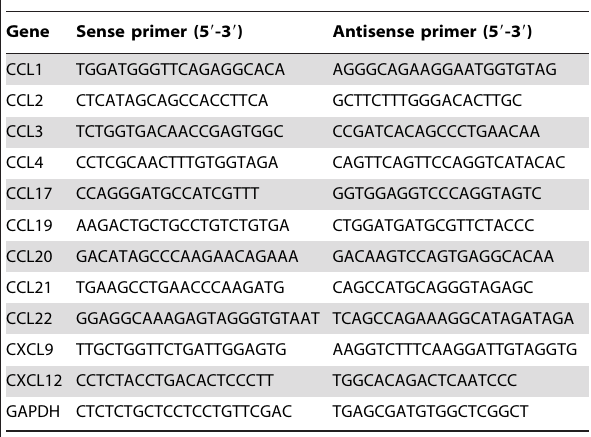
Table 4. Primers for real-time PCR.